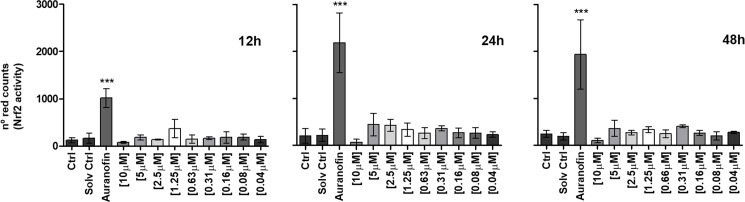
Nrf2 activity in HCT116 cells transfected with the plasmid pTRAF.HCT116 cells were cultured at different concentrations of portoamides, the solvent control was 0.3% DMSO, and fluorescent signals were analyzed with the Incucyte ZOOM software. Statistically significant differences between the solvent control and the treatment groups are indicated by asterisks (One-Way ANOVA, Dunnett’s test, *** = p<0.001.